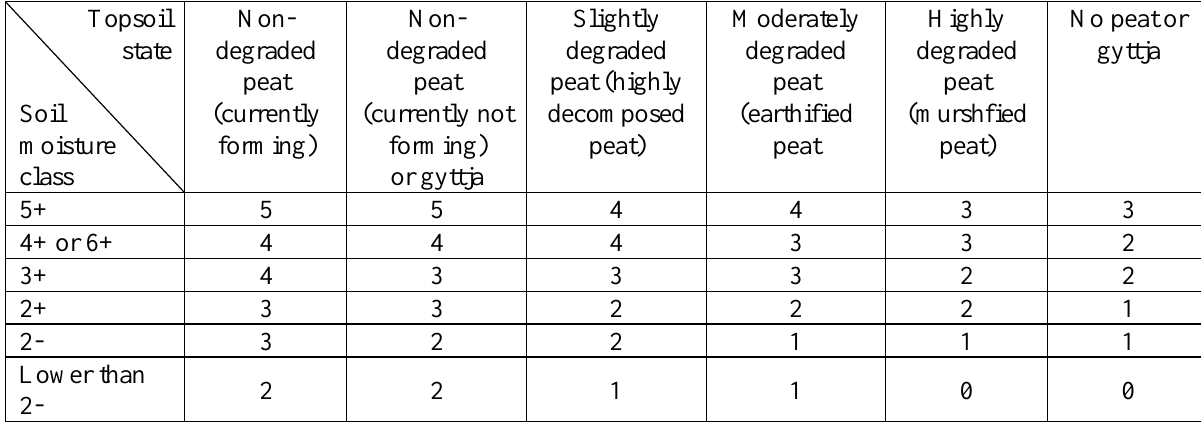
Table 10. Matrix of values for the ‘site characteristics’ indicator, based on soil moisture class and topsoil state (ecosystem